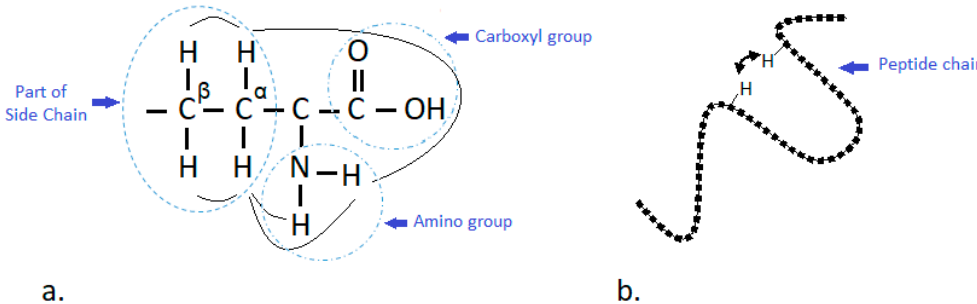
Figure 2. Through bound (scalar) coupling ( a ); through space coupling—nuclear Overhauser effect (NOE) ( b ).